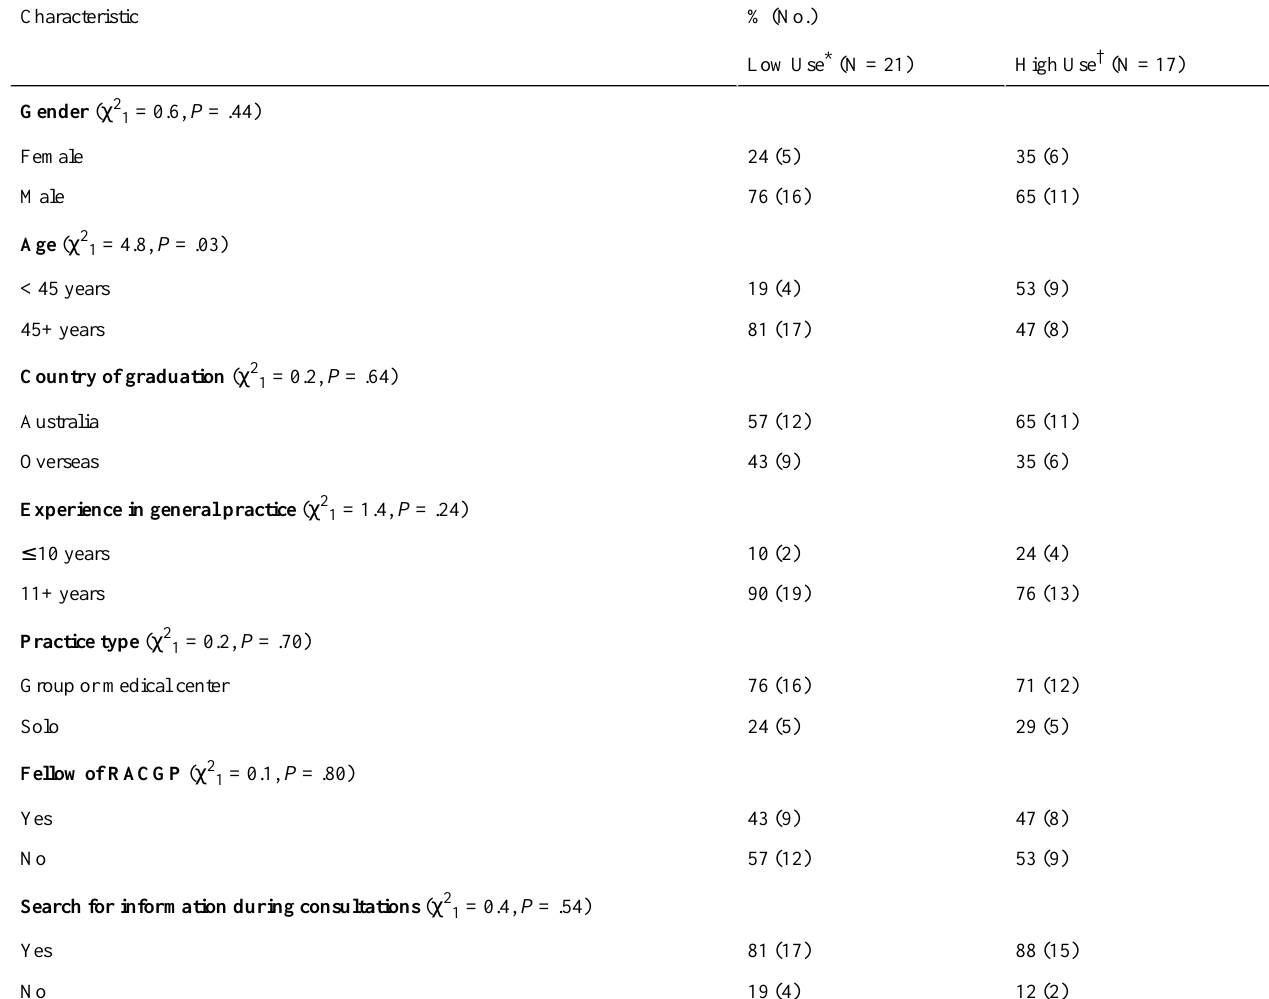
Table 2. Comparison of QC high and low use groups